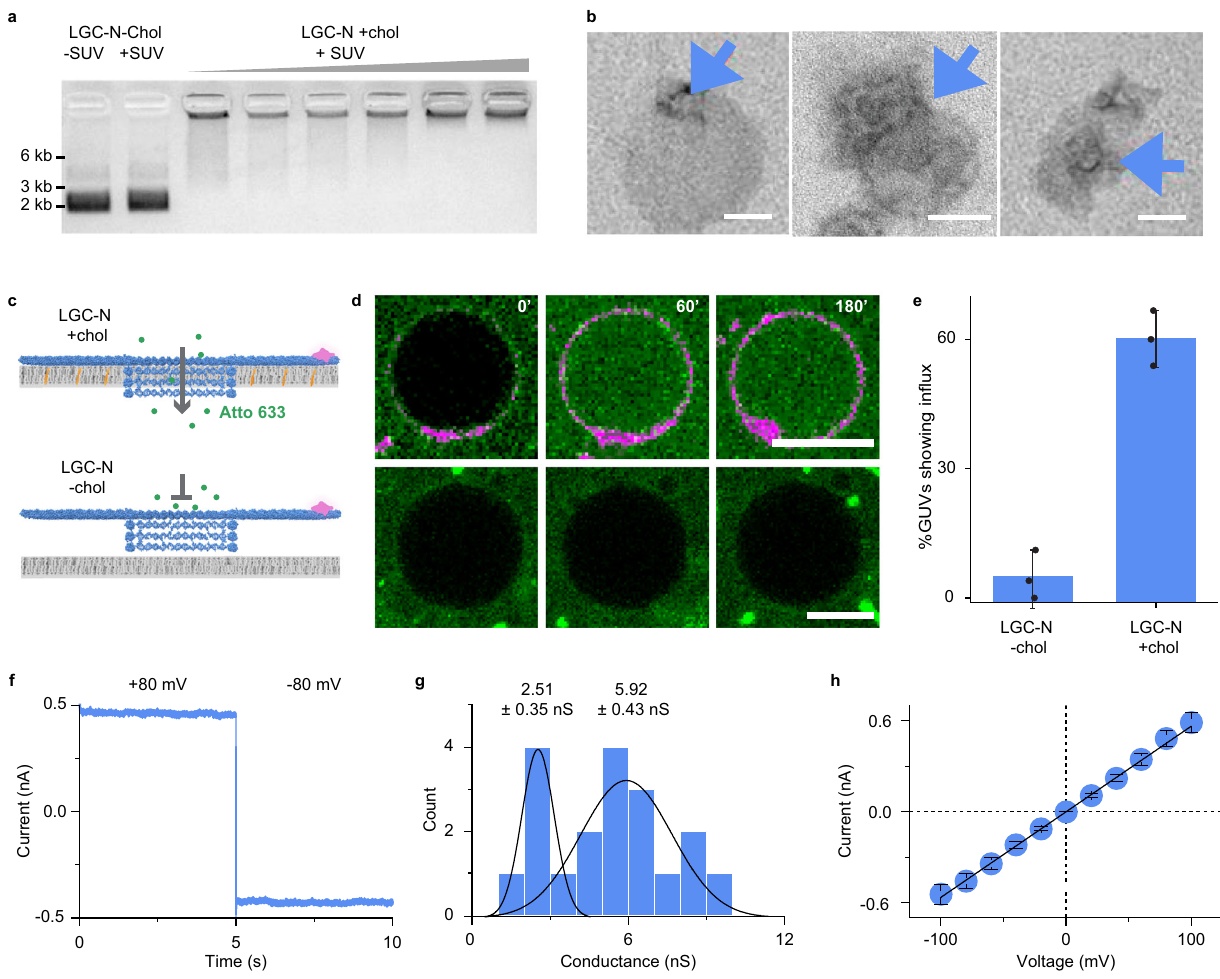
Fig. 2 Insertion and interaction of LGC with lipid bilayers. a 1.5% agarose gel analysis of the DNA pore and its binding activity to lipid membrane vesicles. Lanes from left to right: no lid LGC without cholesterol modi fi cations (LGC-N-Chol) without SUVs, incubated with SUVs (DOPC/DOPE = 7:3, 0.5 mM total lipid), no lid LGC with 64 cholesterol modi fi cations (LGC-N + Chol) incubated with SUVs (total lipid concentration 0, 0.01, 0.025, 0.05, 0.25, and 0.5 mM, respectively). Data are representative of more than three repeats. b Representative TEM images of LGC-N + Chol pores bound to lipid vesicles. Blue arrowheads pinpoint the pores. Scale bars: 50 nm. The data are representative of n = 2 independent experiments. c Scheme of the GUV-dye-in fl ux assay and d a time series of corresponding confocal GUV images with Cy3-labeled LGC (magenta) and Atto633 dye (green). Top: LGC-N + Chol readily interacts with bilayer (magenta circle around GUVs). Their insertion leads to an in fl ux of the Atto633 dye inside the GUV interior. Bottom: LGC-N-Chol does not interact with bilayer (no magenta circle around GUV) or insert into GUV, showing no dye in fl ux over the course of 3 h. The data are representative of n = 3 independent experiments e Bar plot showing the percentage of GUVs with a fi lled interior after 3 h. The data summarize the average percentage of in fl ux and error bars show the standard deviation of mean percentage in fl ux counted from three independent experiments across n = 49 GUVs in case of LGC-N + Chol and n = 59 for LGC-N-Chol. Scale bars: 10 μ m. f Current trace showing a single LGC-N + Chol channel inserted into a planar DPhPC membrane. The trace was recorded at an applied voltage of + 80 mV for the fi rst 5 s after which voltage potential was switched to − 80 mV. g Conductance histogram of 19 individual LGC-N + Chol channels recorded at − 20 mV. h Current-voltage (IV) plot showing the average current of 19 individual insertions ±SEM at membrane potentials ranging from − 100 mV to + 100 mV in 20 mV steps. All electrophysiological experiments were conducted in buffers composed